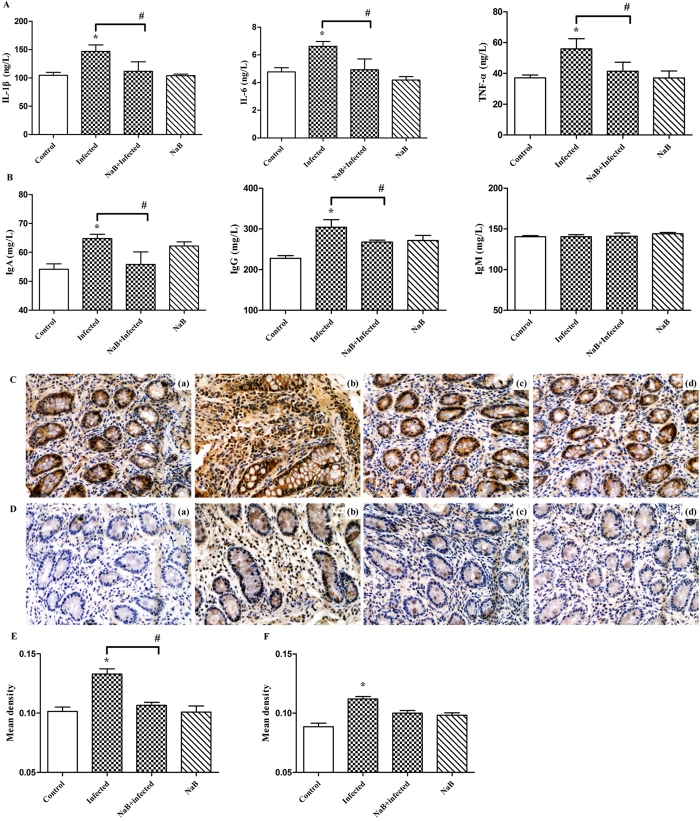
NaB ameliorates the inflammation caused by E. coli O157:H7 infection.Concentrations of serum cytokines (A) and immunoglobulins (B) in NaB− and non-NaB-treated pigs were measured. (C) Representative images of the infiltration of CD68+ cells. Original magnification ×400. Formalin-fixed, paraffin-embedded 5-μm cross-sections were stained with a primary Ab to CD68+. (Ca) Control, (Cb) infected, (Cc) NaB + infected, (Cd) NaB pigs. (D) Representative images of the infiltration of CD177+ cells. Original magnification ×400. Formalin-fixed, paraffin-embedded 5-μm cross-sections were stained with a primary Ab to CD177+. (Da) Control, (Db) infected, (Dc) NaB+infected, (Dd) NaB pigs. Optical density of the CD68+ macrophage infiltrate (E) and the CD177+ neutrophil infiltrate (F). Four to six microscopic fields were randomly selected from each sample. Data plotted represent the mean ± SEM. *Indicates a significant difference (p < 0.05) compared to that of control group by One-way ANOVA. #Indicates a significant difference (p < 0.05) compared to that of infected group by One-way ANOVA.